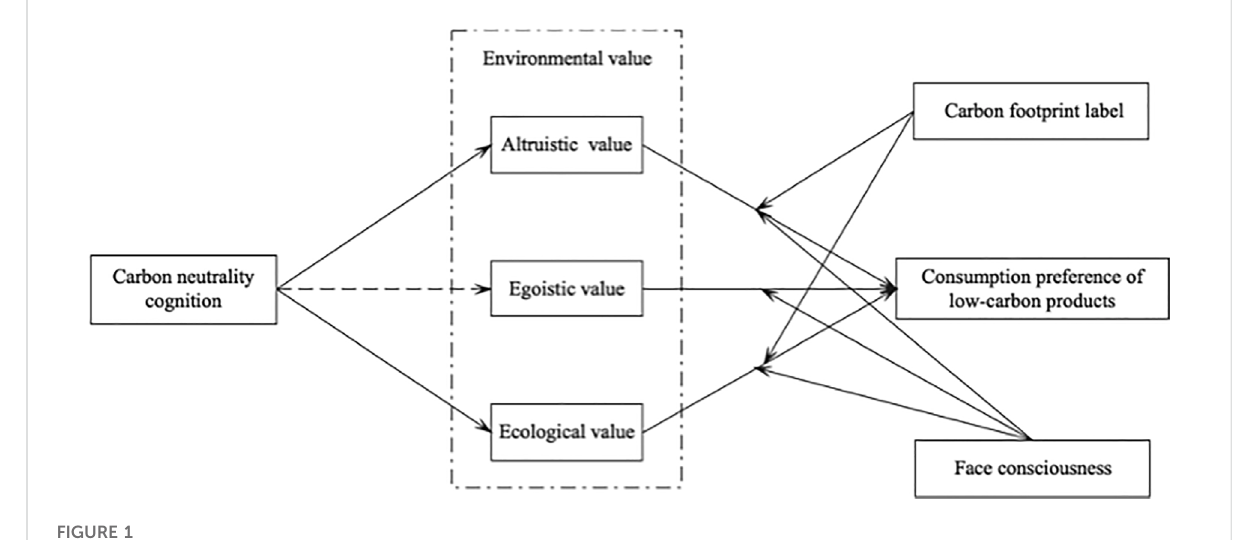
FIGURE 1 Research model